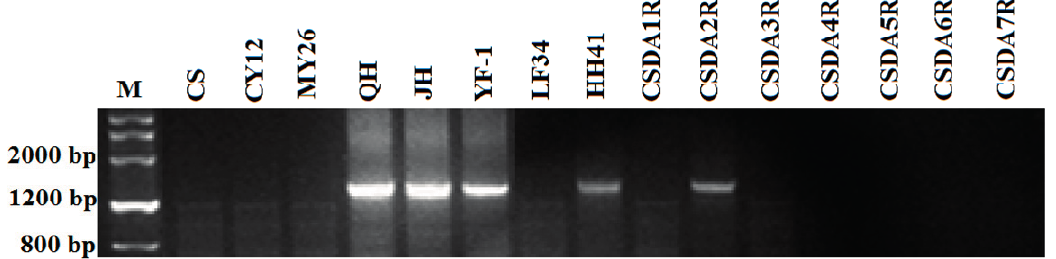
Figure 2. PCR patterns of Sec2 for wheat lines (CS, CY12 and MY26), S. africanum , S. cereale cv. JZHM, wheat— S. africanum amphiploid (YF-1), 2R afr (2D) substitution (LF34), 6R afr (6D) substitution (HH41) and CS— S. cereale cv. Imperial addition lines (CSDA1R to